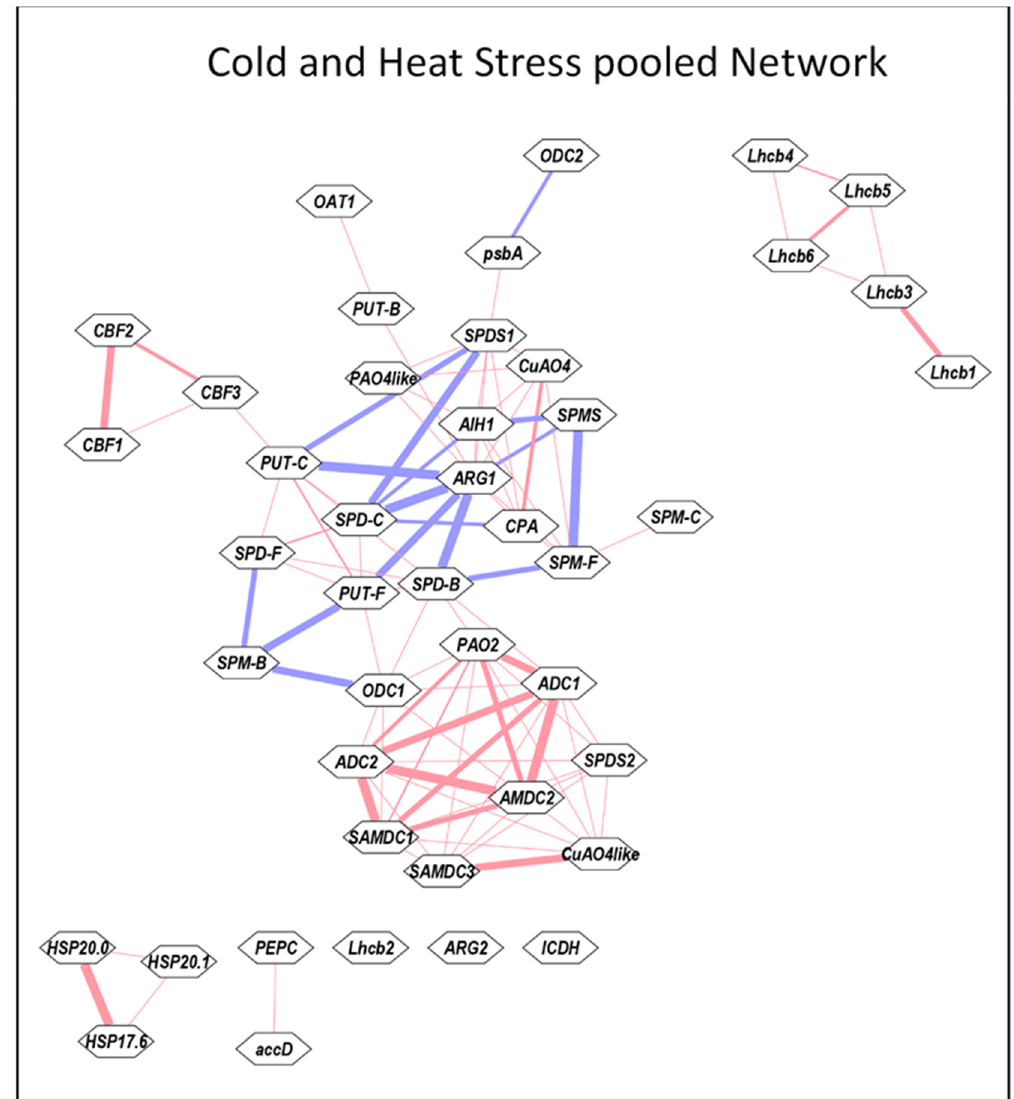
Figure 7. Cytoscape analyses of Pooled data from heat and cold stresses. All values for the active and the variable parameters were normalized as % initial 0 time point. Before determining correlation coefficient r , data for each parameter was pooled individually from heat and cold stresses. The correlation coefficients were determined using Microsoft EXCEL. These data were analyzed using the Expression Correlation app of the Cytoscape program [65]. Gene abbreviations are the same as in the Table S1.